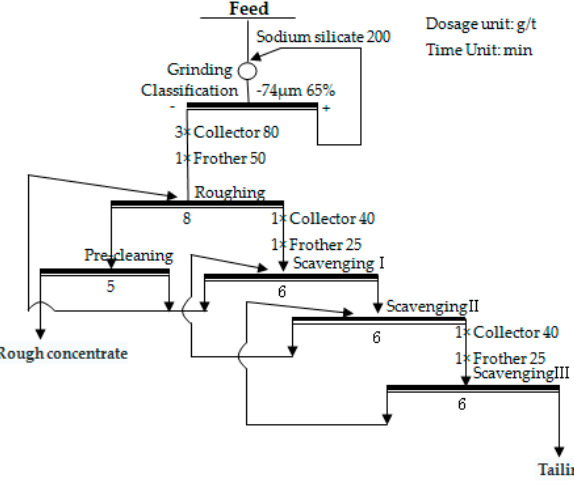
Figure 3. Industrial-scale tests flow-sheet and reagent conditions.